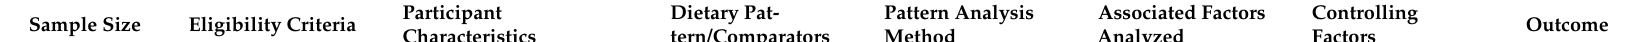
Table 2. Characteristics of cohort studies analyzing the factors associated to fruits and vegetables